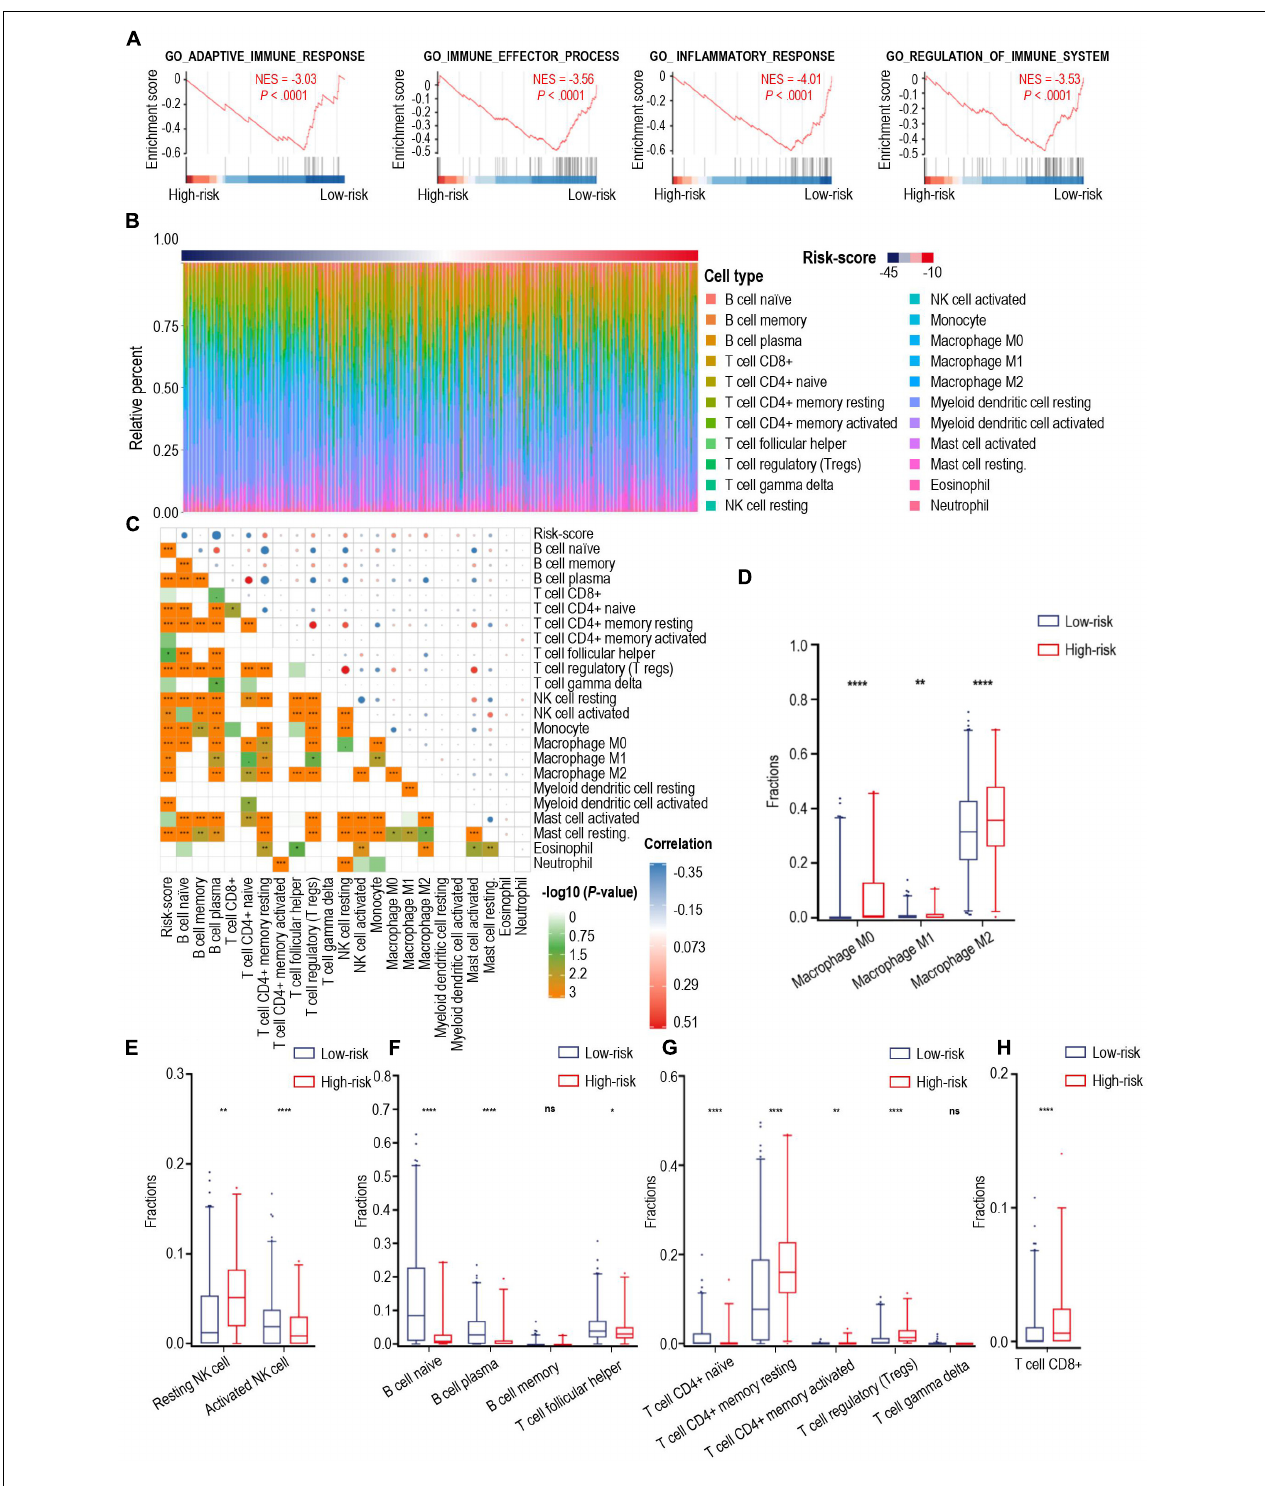
FIGURE 3 | The landscape of immune infiltration in high- and low-risk patients with gliomas. (A) GSEA of significant immune-associated biological process between high- and low-risk patients with glioma. (B) The relative proportion of 22 immune cell infiltration in the TCGA cohort. Immune cell types were defined through CIBERSORT. (C) Pearson correlation matrix of risk score and 22 immune cell proportions including B cells, CD8 + T cells, CD4 + T cells, NK cells, monocytes, macrophages, myeloid dendritic cells, mast cells, eosinophil cells, and neutrophil cells. (D–H) Box-plots of fractions of macrophages (D) , NK cells (E) , B cells, T helper cells (F) , CD4 + T cells, gamma delta T cells (G) and CD8 + T cells (H) between high- and low-risk group. p -value: *, < 0.05; **, < 0.01; ****, < 0.0001; ns, not significant.